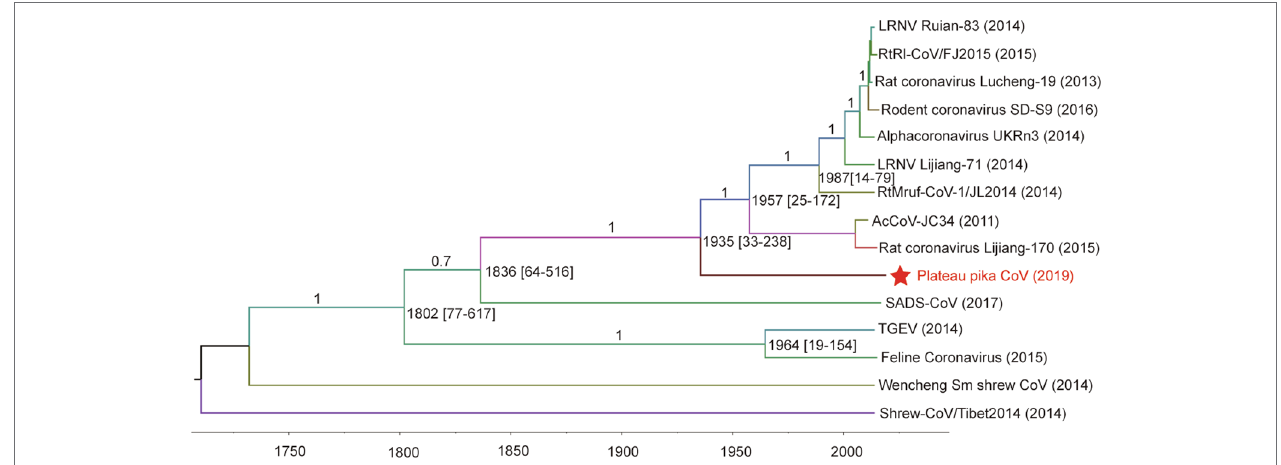
FIGURE 4 | Estimation of the tMRCA of PPCoV based on RdRp genes. The analysis was conducted using BEAST version 1.10 under the SRD06 model and relaxed molecular clock. The mean times of tMRCA are labeled at each node including HPDs in square brackets. The posterior values are labeled at corresponding branches. Brackets after taxa are labeled with sampling time. Labeled nodes are the corresponding mean estimated dates. The virus from this study is labeled with red font and a red star.